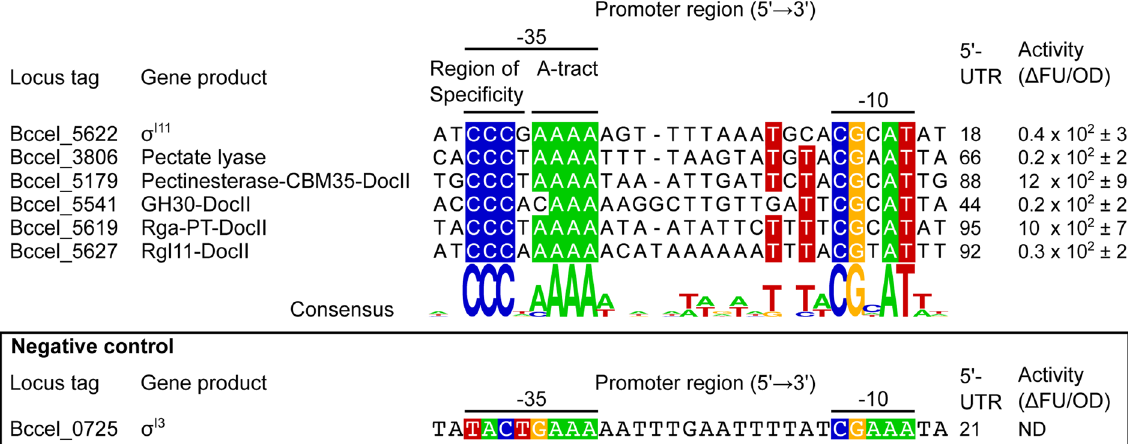
Figure 4. Alignment of P. cellulosolvens σ I11 -dependent promoter sequences and quantitative evaluation of their recognition by the P. cellulosolvens σ I11 factor. The WebLogo was generated with the sequence shown in the alignment. Distances between the promoter region sequences used for the alignment and the first codon of corresponding genes are shown in the 5 ′ -UTR (5 ′ -untranslated region) column. Promoter activity was measured by quantifying the fluorescence (average of three independent experiments). Fluorescence units (FU) were calculated when cells reached an optical density (600 nm) of 1. Δ FU represents the activity of the induced promoter after subtracting the fluorescence obtained under uninduced conditions. ND (not detected) was assigned where Δ FU was negative, zero or the standard deviation exceeded Δ FU. As a negative control, the predicted σ I -dependent promoter of the P. cellulosolvens σ I3 gene was used. CBM,